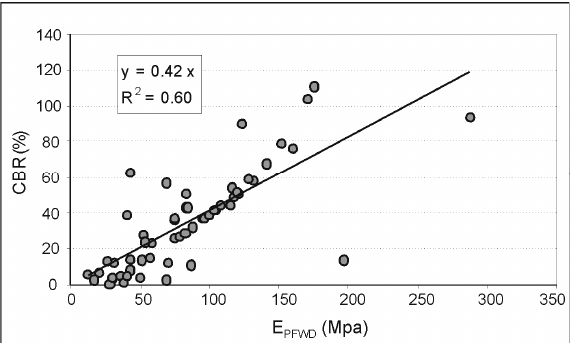
Fig. 8. Linear regression model based on different studies